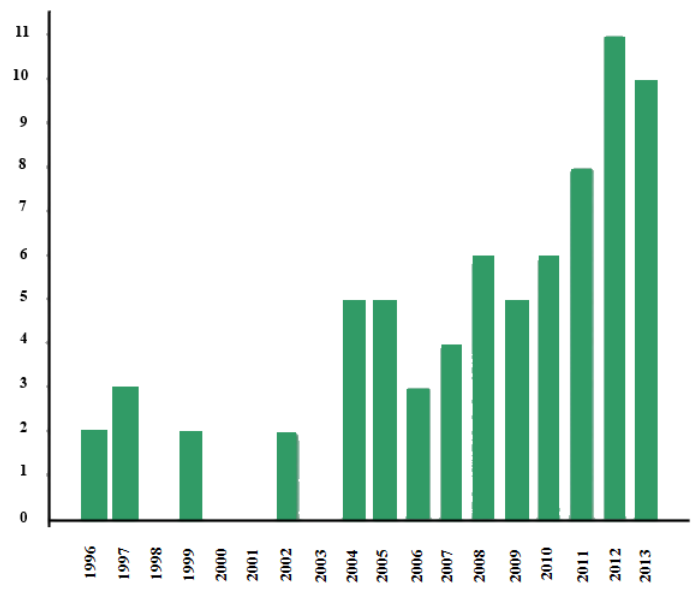
Figure 1. Graph of studies on virtual reality and